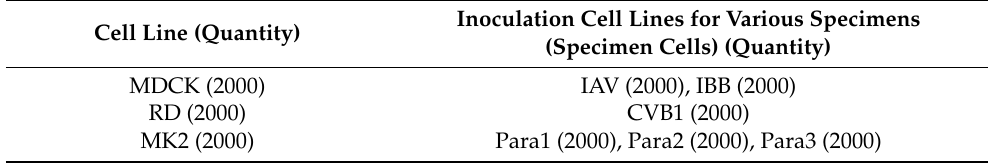
Table 2. Nine most frequently encountered categories of cell lines and specimen cells with the corresponding quantities (selected by testing personnel). Due to data balancing, 500 images of each category are chosen and quadrupled to 2000 images for model